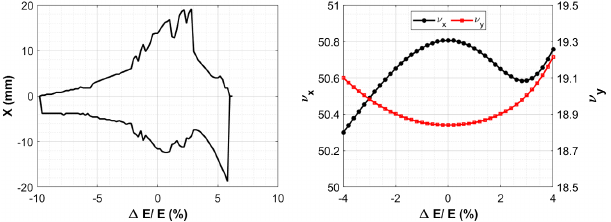
FIG. 20. Energy acceptance with Y 0 ¼ σ y ¼ 4 . 243 μ m (left) and bandwidth (right) of SKIF with RF OFF.